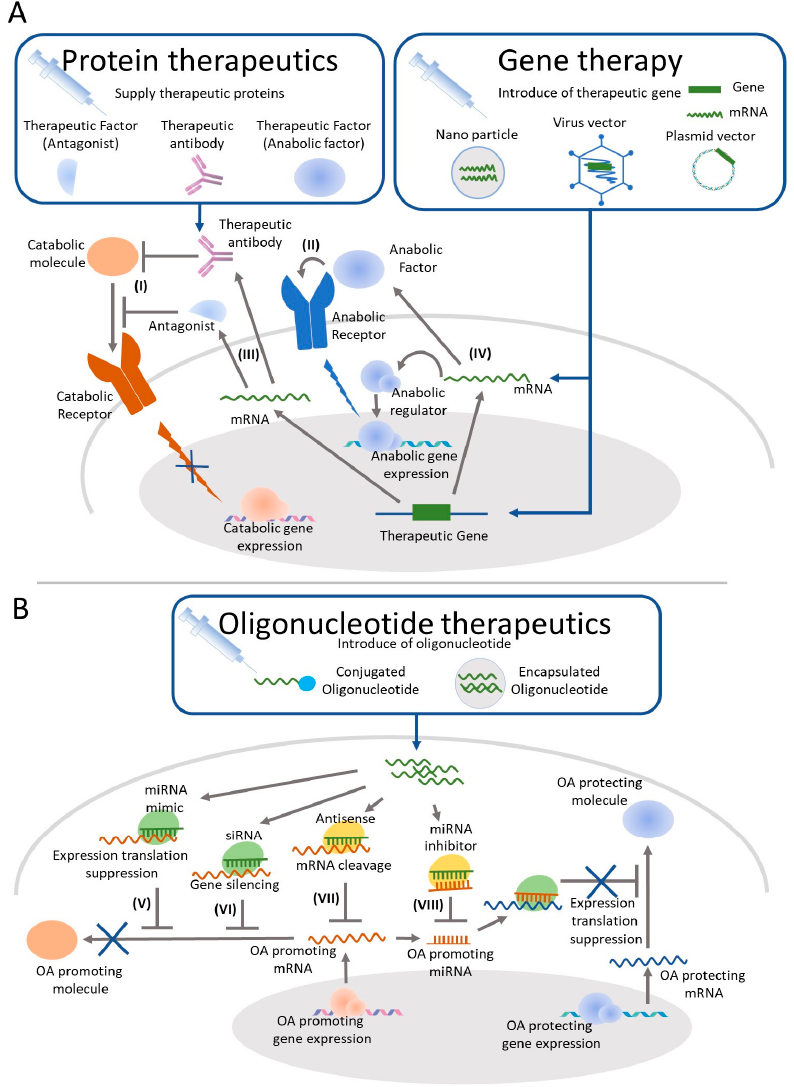
Figure 1. Current and potential targets of DMOADs for IA injection. ( A ) Current drug targets of protein therapeutics candidates for OA aim to block the interaction between proinflammatory cytokines and their receptors (I) or to supply cartilage protective proteins to the joint (II). The attempts of gene therapy candidates aim to supply proteins, which have anti-inflammatory (III) or cartilage repair effects (IV) instead of IA administration of recombinant protein. ( B ) OA progression may be controlled by reducing the protein production involved in pathological conditions through expression translation suppression by miRNA (V), gene silencing by siRNA (VI), or mRNA cleavage by antisense (VII). MicroRNA inhibitors inhibit OA promoting miRNAs (VIII) and may restore the expression of OA protecting proteins and may contribute to suppress OA